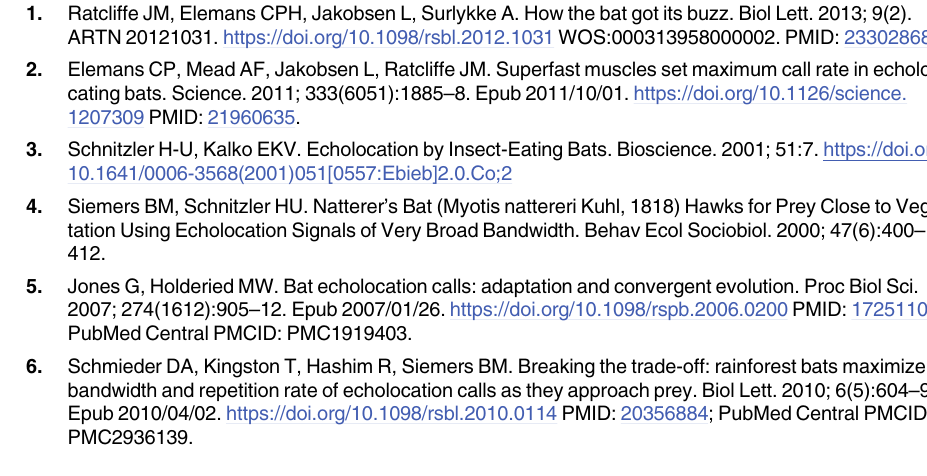
S6 Data. The data underlying Fig 4A and 4B, vocal membrane f fold f range in vitro, and f range of agonistic social calls of M . daubentonii . File contains o o extracted f o